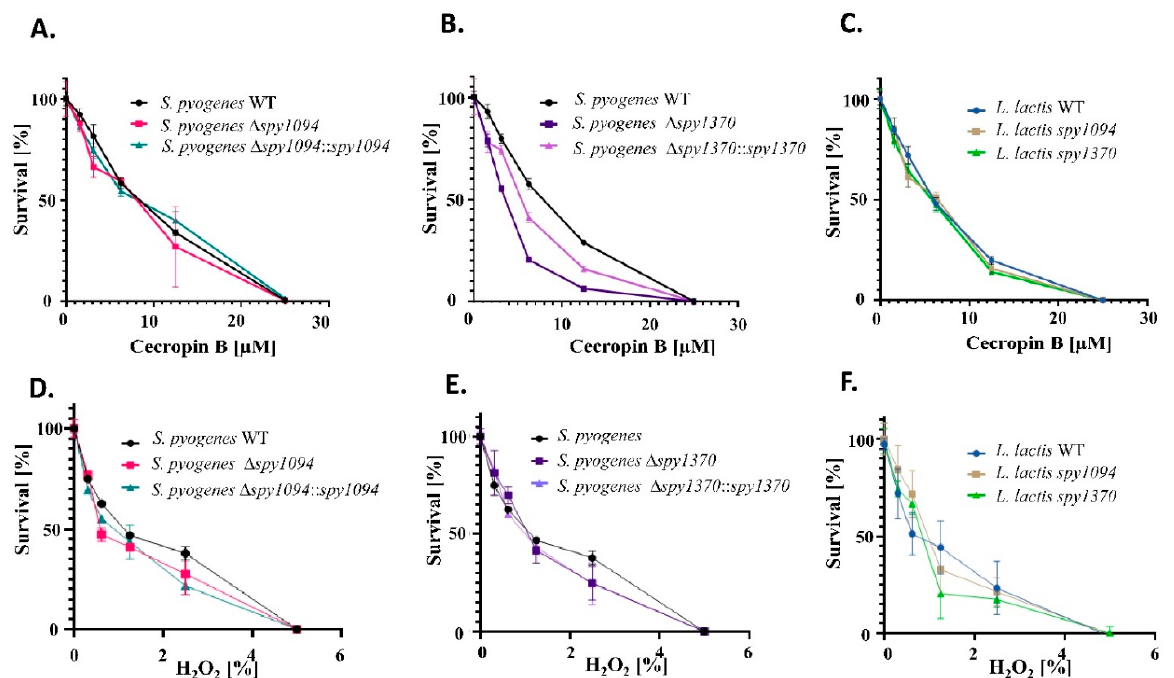
Figure 4. Survival of wild ‐ type and mutant strains after treatment with the CAMP cecropin B or with H 2 O 2 . Wildtype and mutant strains were grown to mid ‐ exponential phase (OD 600 = 0.6–0.8), with H 2 O 2 . Wildtype and mutant strains were grown to mid-exponential phase (OD 600 = 0.6–0.8), treated with cecropin B at various concentrations (0–25 μ M) and incubated for another 3 h at 37 ° C. treated with cecropin B at various concentrations (0–25 µ M) and incubated for another 3 h at 37 ◦ C. ( A,B ) S. pyogenes wildtype and mutants. ( C ) L. lactis wild ‐ type and mutants. To measure suscepti ‐ ( A,B ) S. pyogenes wildtype and mutants. ( C ) L. lactis wild-type and mutants. To measure susceptibility bility to oxidative killing, bacteria were treated with H 2 O 2 at concentrations of 0–5% and incubated for another 30 min at 37 ° C. ( D,E ) S. pyogenes wildtype and mutants. ( F ) L. lactis wild ‐ type and mu ‐ tants. Surviving bacteria were enumerated by spot plating in triplicates on agarose. Data are mean values from two independent experiments ( A – C ) or four independent experiments ( D – F ) in tripli ‐ cates +/ − SD. Notably, the S. pyogenes  spy1370 mutant showed decreased growth in culture medium which could be restored in a complementation mutant (Figure 2A). could be restored in a complementation mutant (Figure